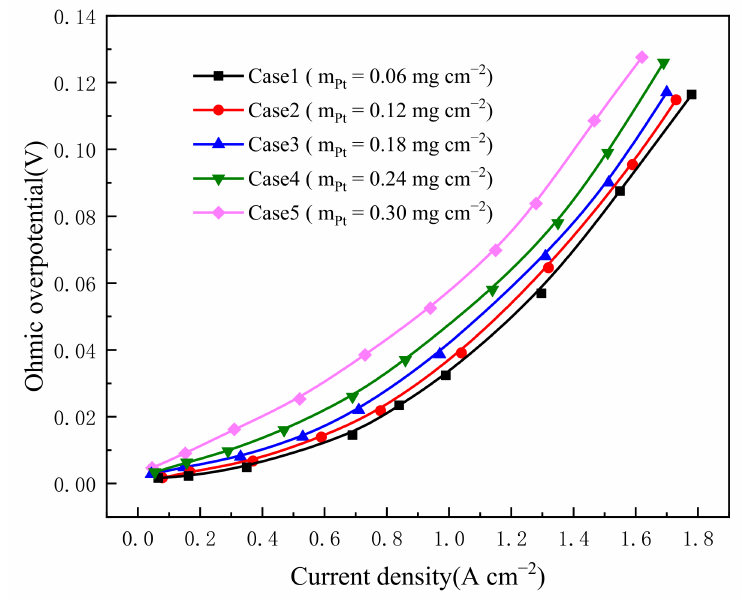
Figure 10. Effect of Pt loading on Ohmic